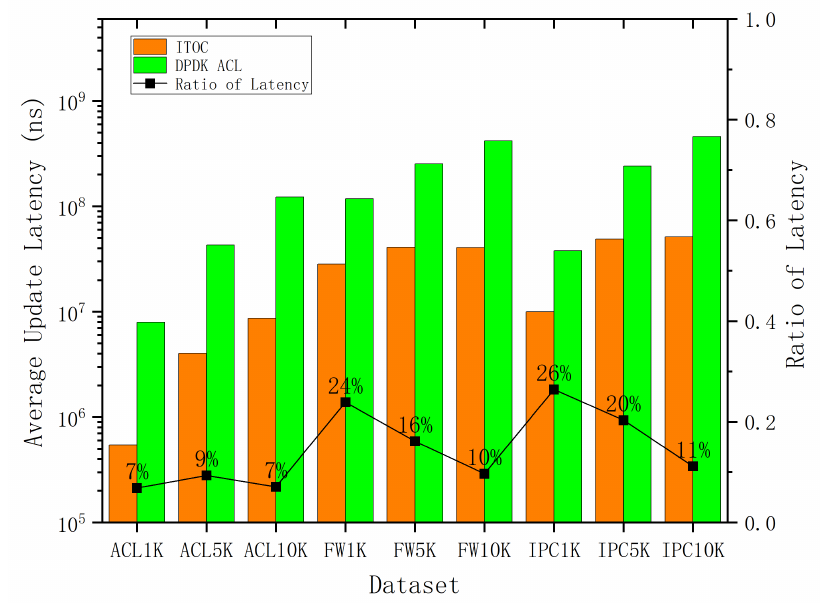
Figure 9. Average update latency